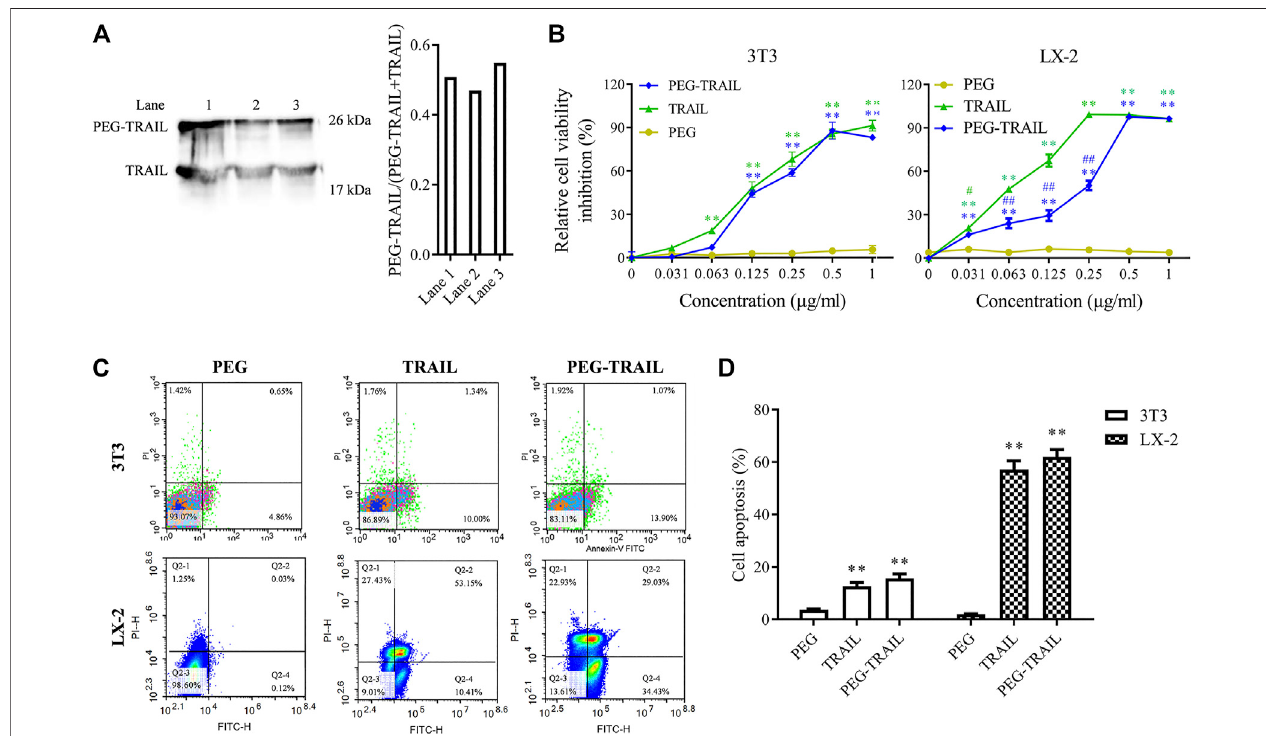
FIGURE 1 | PEG-TRAIL attenuates the viability and promotes apoptosis of 3T3 and LX-2 cells. (A) Successful synthesis of PEG-TRAIL was veri fi ed with Western blotting. (B) Cell viability of 3T3 and LX-2 cells treated with PEG, TRAIL, and PEG-TRAIL was measured with CCK-8 assay. (C) Cell apoptosis of 3T3 and LX-2 cells treated with PEG, TRAIL, and PEG-TRAIL was detected by fl ow cytometry assay. (D) Statistical result of cell apoptosis assay. * p < 0.05 and ** p < 0.01 compared with PEG; # p < 0.05 and ## p < 0.01 compared with